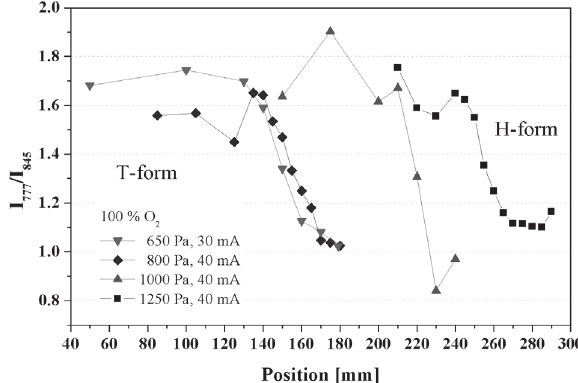
Figure 5: Longitudinal profile of the relative intensity of the atomic oxygen lines I /I for different pressures. The transition region 777 845 between the T-form and H-form can be clearly seen and corresponds to the change in visible